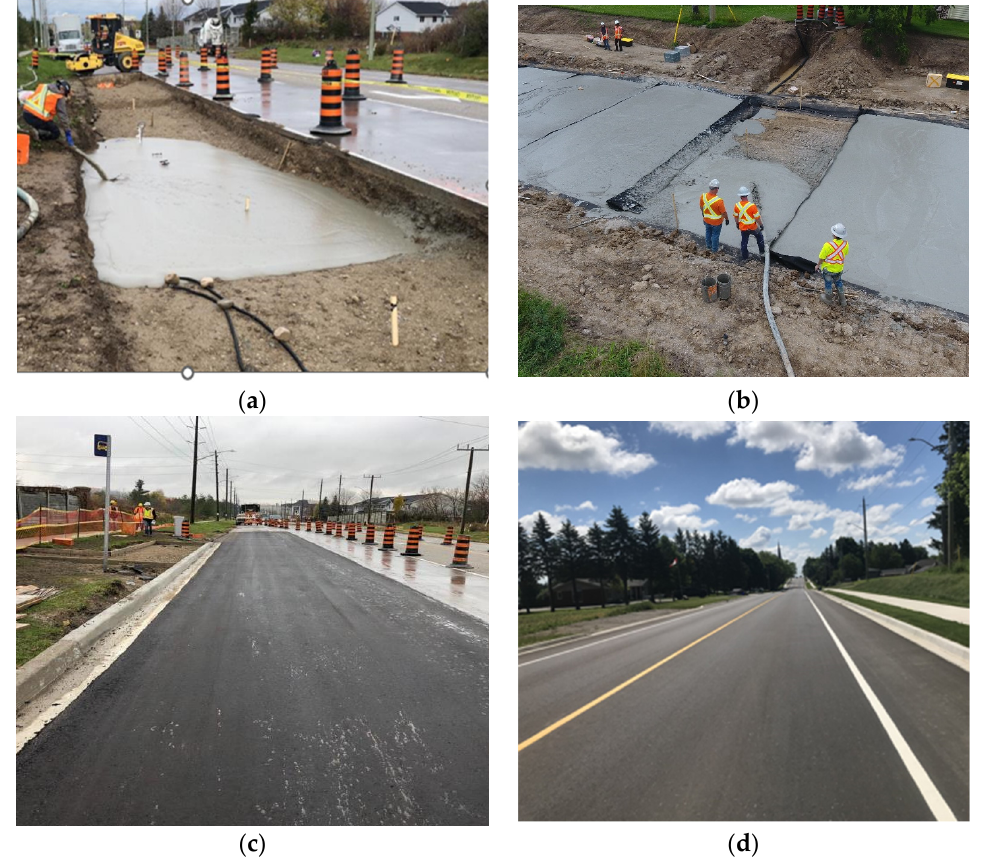
Figure 1. Construction and completed Erbsville and Notre Dame Drive (NDD) pavement sections: ( a ) Erbsville LCC pour; ( b ) NDD LCC pour; ( c ) Erbsville completed pavement; ( d ) NDD completed pavement.